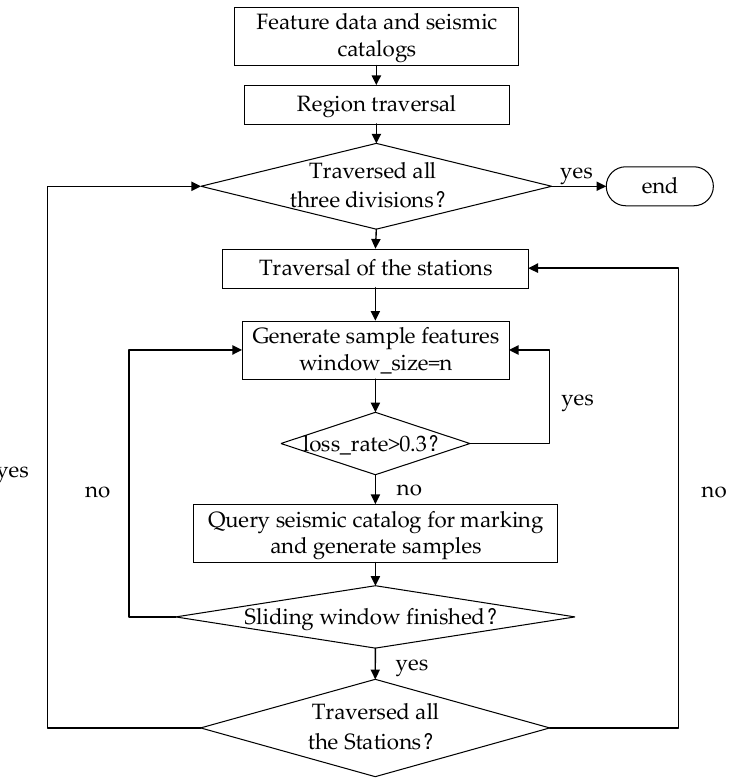
Figure 2. The process of sample construction.